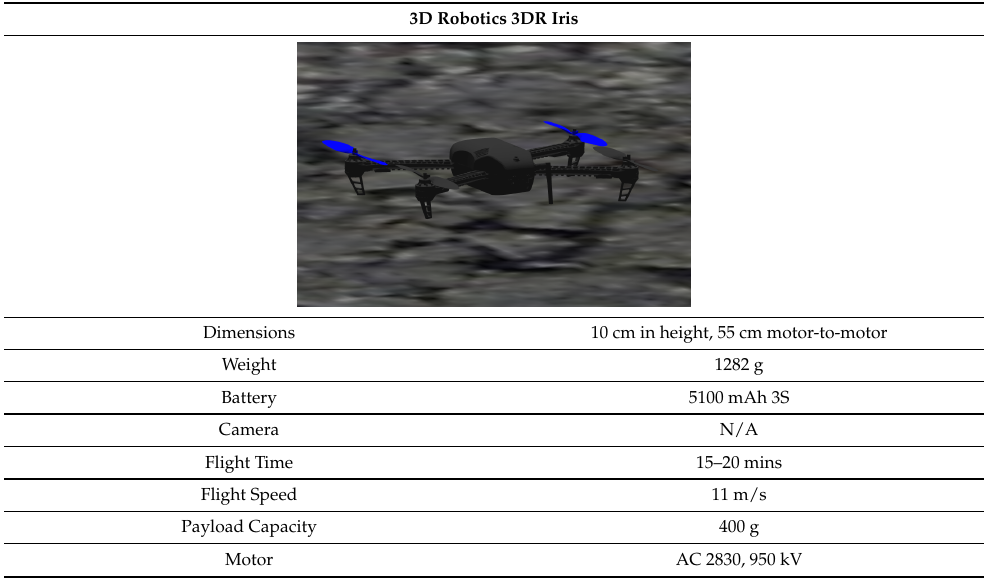
Table A5. 3D Robotics UAV 3DR Iris technical